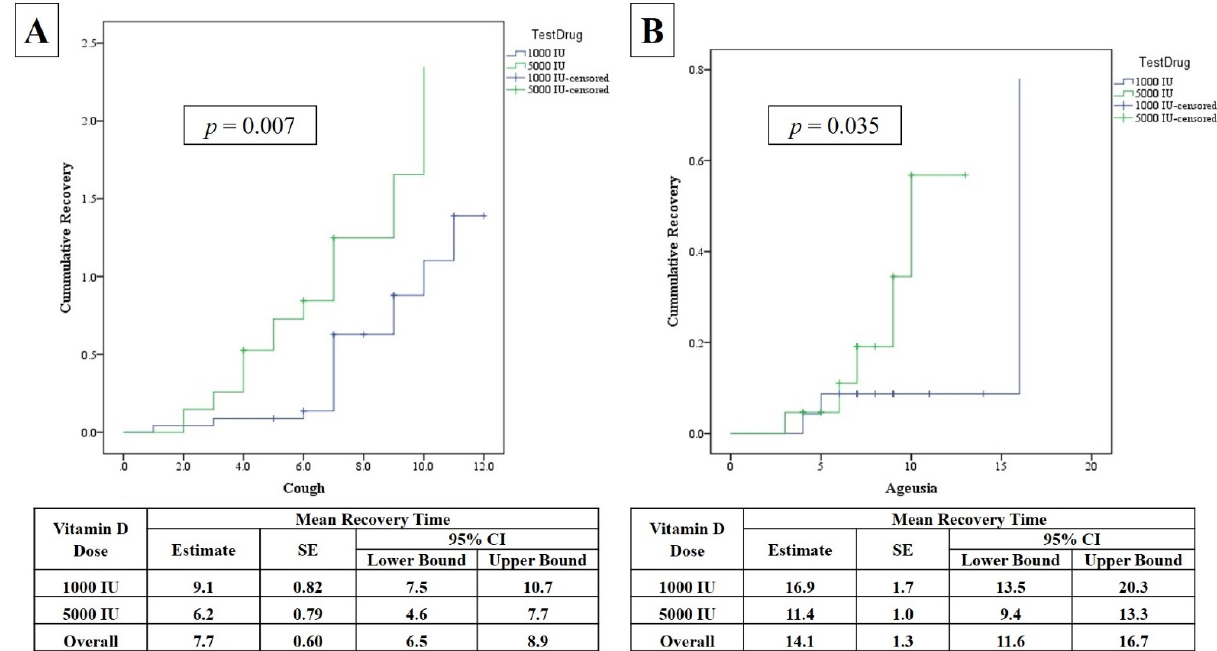
Figure 2. Unadjusted Kaplan–Meier Plot showing the recovery times for cough ( A ) and ageusia ( B ) according to vitamin D dose.